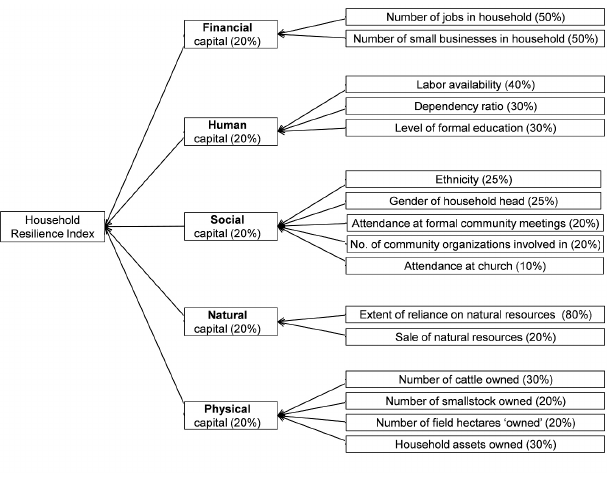
Fig. 5 . List and weighting of indicators used to calculate the household resilience index, based on Vincent’s Household Adaptive Capacity Index